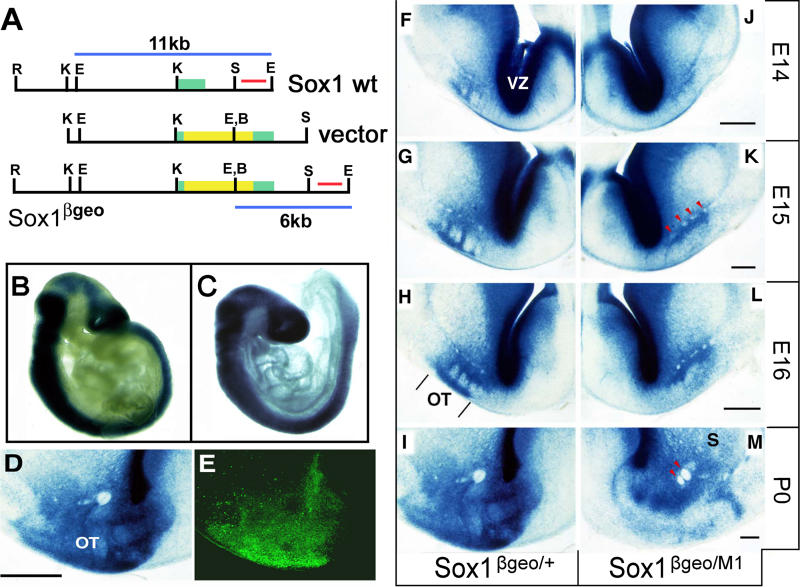
The Mouse Sox1
βgeo Allele Reveals the Requirement of SOX1 in the Development of VS Neurons(A) Strategy for targeting of the Sox1 locus by insertion of βgeo. Restriction enzymes: RV, EcoRV; K, KpnI; E, EcoRI; S, SpeI; B, BamHI. Yellow boxes indicate βgeo, green, SOX1 exon, and blue lines indicate fragments appearing in Southern blots of EcoR1-digested genomic DNA, hybridized with the external probe, which is shown with red lines.(B–E) X-gal and SOX1 antibody staining of Sox1
βgeo/+. Comparison of Sox1
βgeo expression visualized by X-gal staining (B and D) and the endogenous wild-type Sox1 gene visualized by whole-mount in situ (C) and SOX1 antibody staining (E). (B and C) show E9-stage embryos and (D and E) show coronal sections of newborn ventral telencephalon.(F–M) 100-μm coronal sections (Vibratome) were stained with X-gal to identify cells with Sox1 promoter activity. (F–I) show Sox1
βgeo/+ forebrain sections from E13 to birth (P0) showing normal migration of Sox1-expressing cells from the VZ to the site of the OT, including striatal bridges. (J–M) show sections of Sox1
βgeo/M1 forebrain, showing absence of X-gal staining in the OT and the striatal bridges. Red arrowheads show the anterior commissure.Scale bar = 500 μm for (B) and (C) and 300 μm for (D–M).